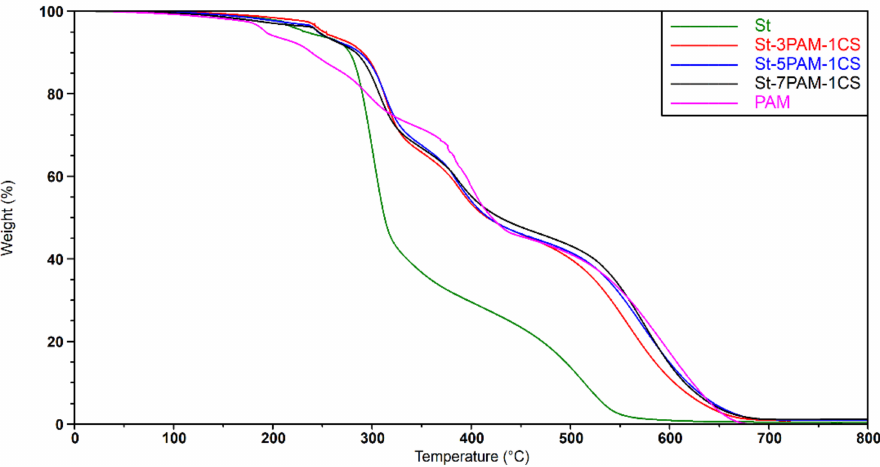
Figure 5. Thermogravimetric analysis (TGA) thermographs for potato starch (St), polyacrylamide (PAM), and starch grafted polyacrylamide hybrids with 1 wt.% of CSs and different St:AM molar ratio: 1:3 (St-3PAM-1CS), 1:5 (St-5PAM-1CS), and 1:7